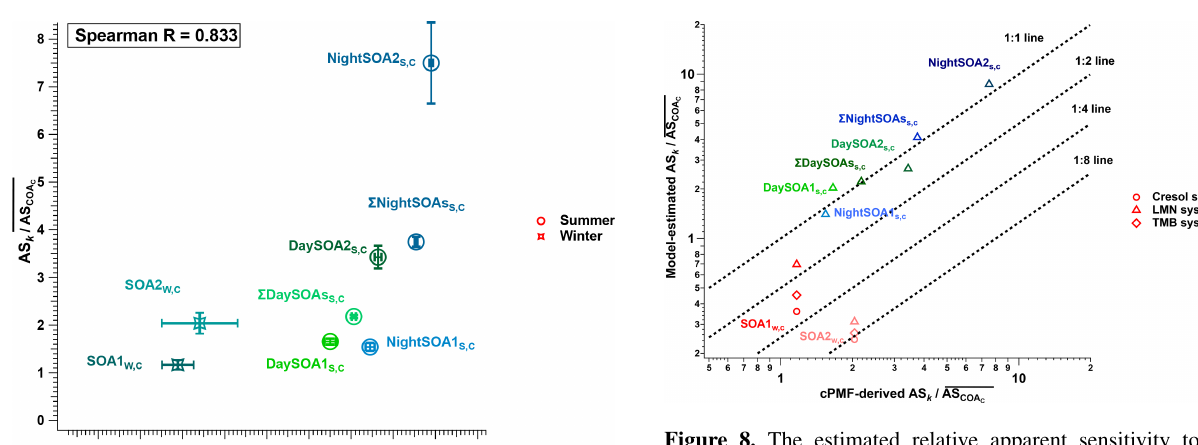
Figure 8. The estimated relative apparent sensitivity to COAs (AS k / AS COA ) from the gradient-boosting regression (GBR) C model as a function of cPMF-derived relative apparent sensitivity to COA (AS k / AS COA ). The symbols indicate the different oxida- C tion precursor systems (LMN for SOAs produced from oxidation of limonene by ozone, cresol and TMB for SOAs produced from oxidation of o-cresol and 1,3,5-trimethylbenzene by OH radicals,